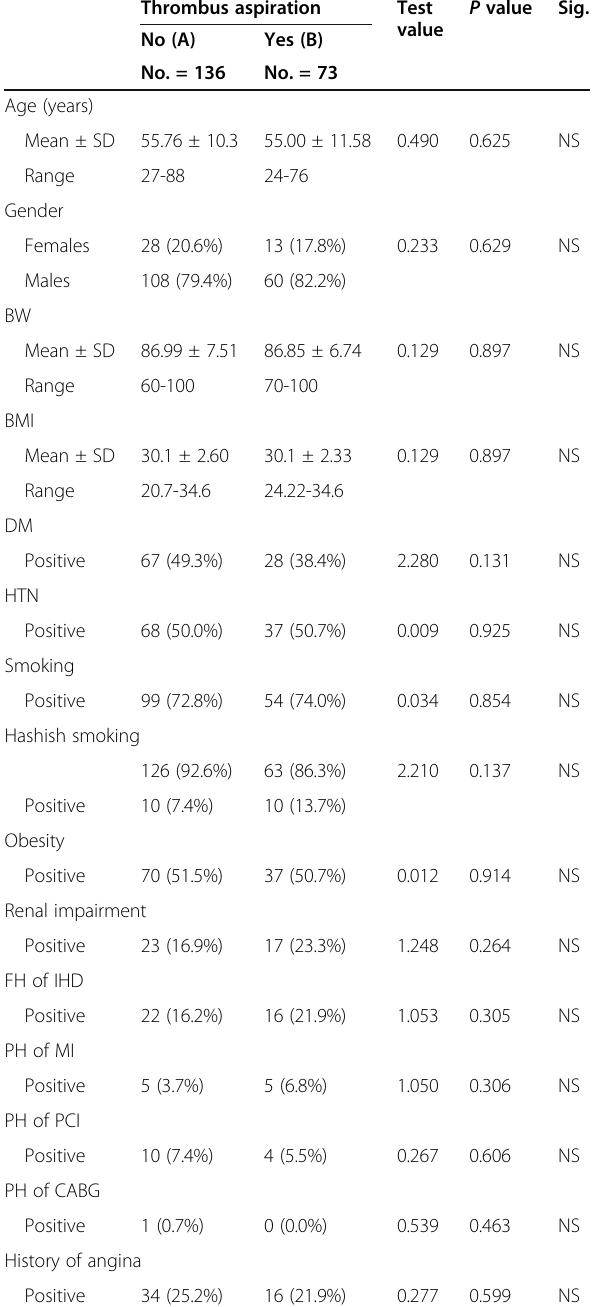
Table 1 Comparison between 2 groups regarding clinical features